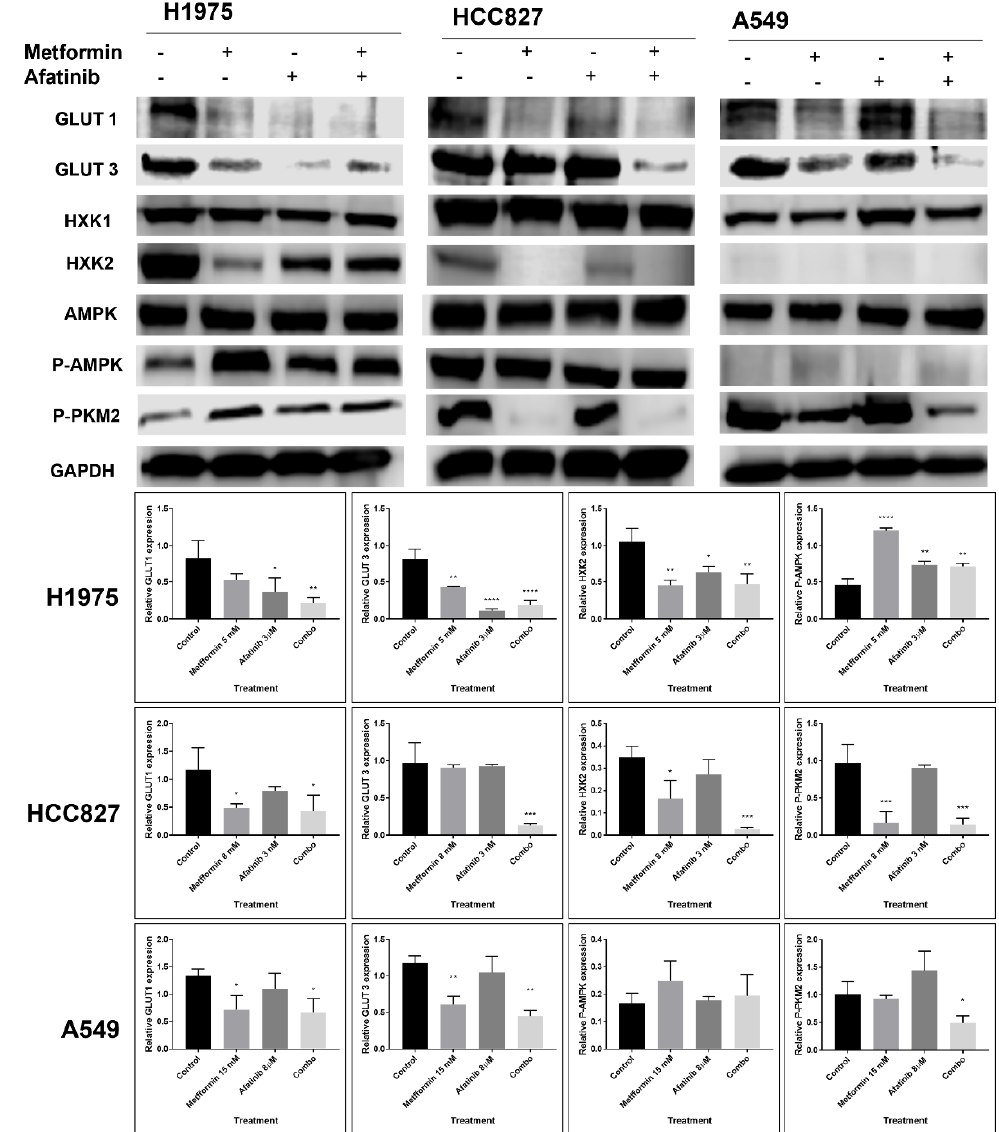
Figure 6. Effect of metformin–afatinib combined treatment on glycolytic enzymes and proteins. Cells were seeded and treated for 72 h with their respective metformin–afatinib concentrations. GAPDH was used as constitutive control, Western blot images were analyzed by image (NIH) and represented as bars. Images are representative of three independent experiments and results of area are presented as mean ± SD. Data were normalized regarding endogenous control and statistically analyzed by one-way ANOVA. * p ≤ 0.05, ** p ≤ 0.01, *** p ≤ 0.001, **** p ≤ 0.0001.